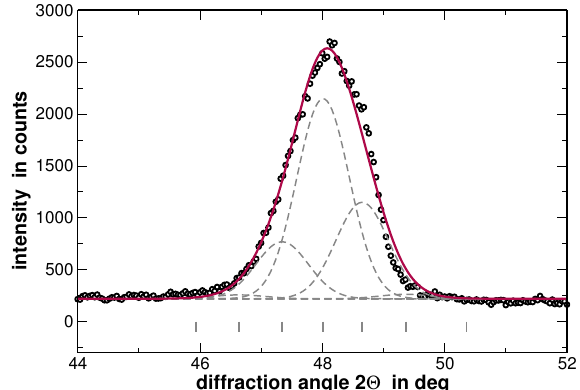
Figure 7. Reflection 111 of AuCuNiPt in the segregated state and seven underlying Gaussian shape reflections of the fractions of which the center positions were indicated. The center positions arise from the average composition within the fractions from which the lattice parameter and in consequence the diffraction angle was